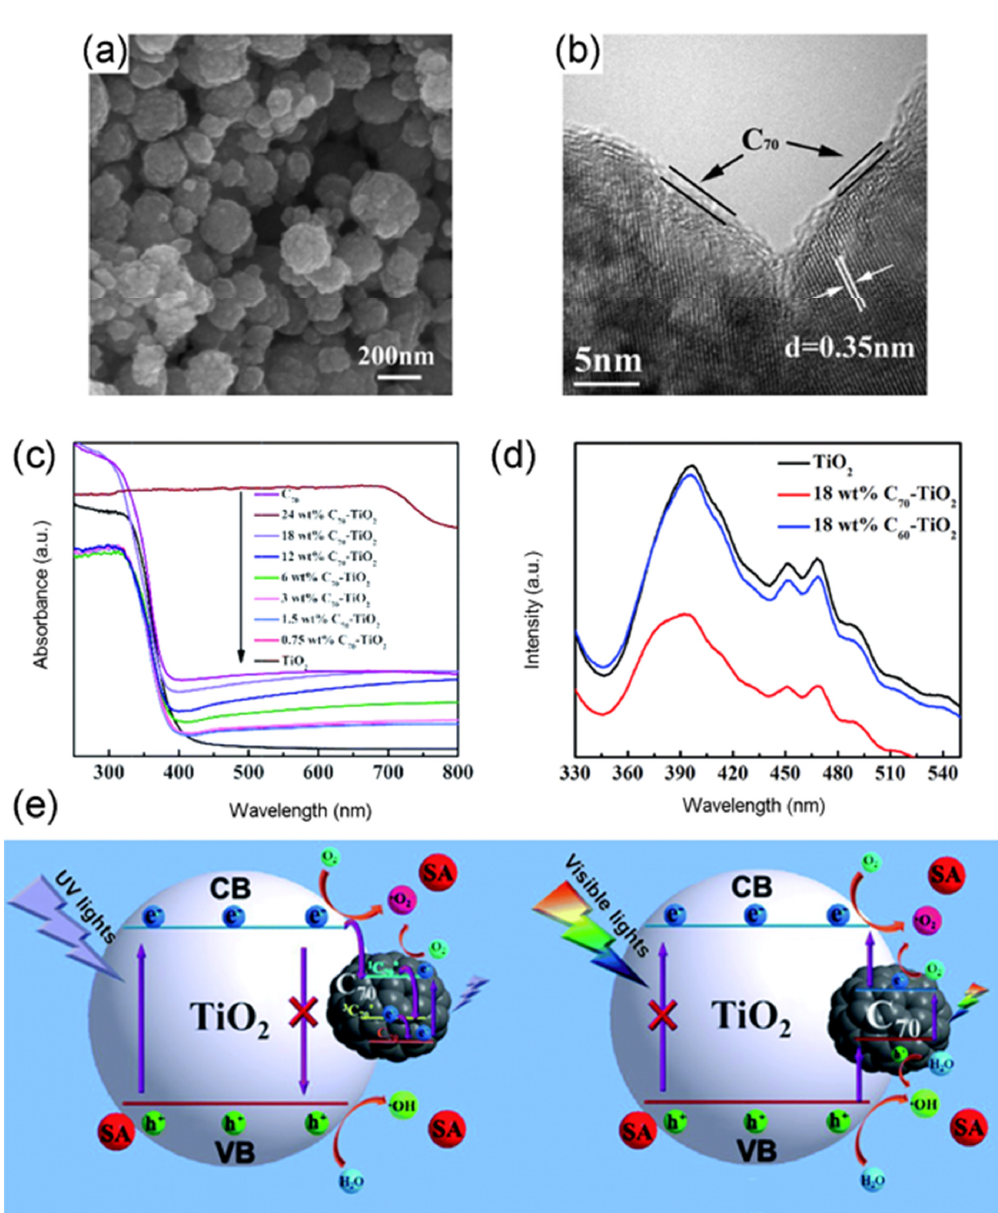
Figure 3. SEM ( a ) and TEM ( b ) images of 18 wt % C 70 -TiO 2 . ( c ) UV-Vis DRS of the C 70 -TiO 2 and pure TiO 2 . ( d ) Comparison of PL spectra over C 70 -TiO 2 , C 60 -TiO 2 and TiO 2 . ( e ) Photocatalytic mechanisms of C 70 -TiO 2 under UV and visible light illumination. Reproduced with permission from Reference [69]. Copyright 2015,